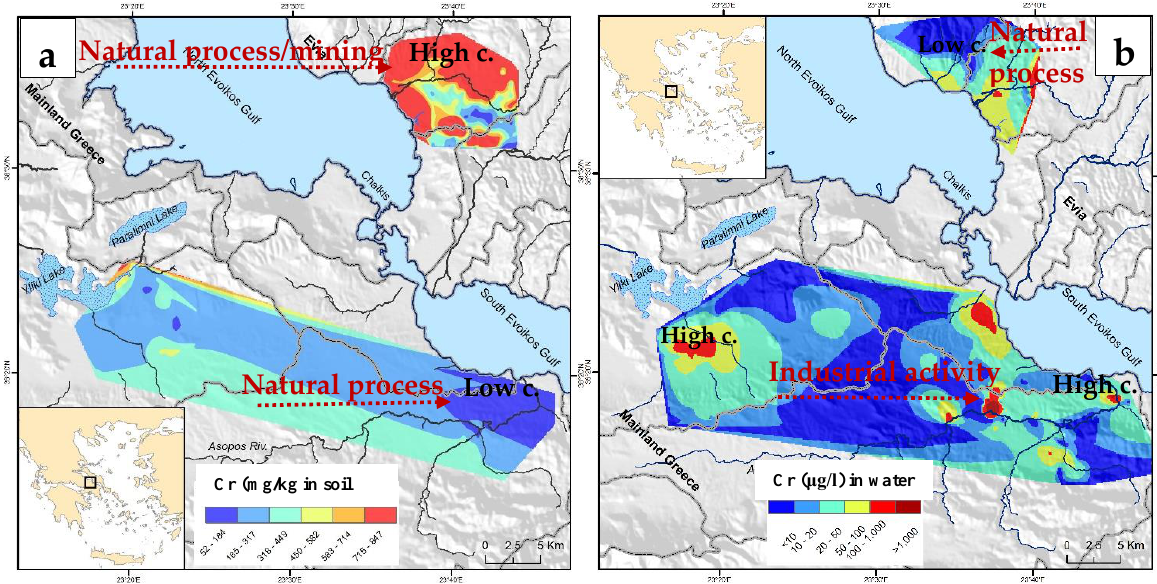
Figure 3. Maps showing spatial distribution of Cr in soils due to natural processes and mining of Fe-Ni laterites ( a ), and in groundwater from the Evia and Assopos–Thiva basins due to natural processes, mining, and industrial activity ( b ) [30].